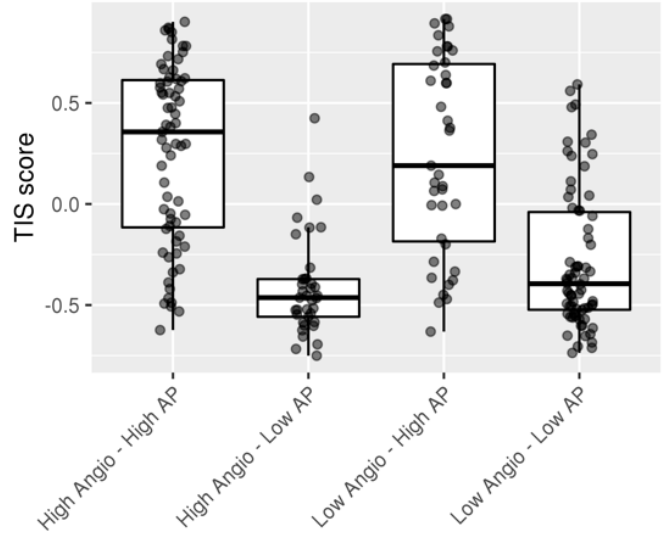
Figure 4. Boxplot showing T-cell inflammatory signature (TIS) score across the four Angio-AP combination groups.